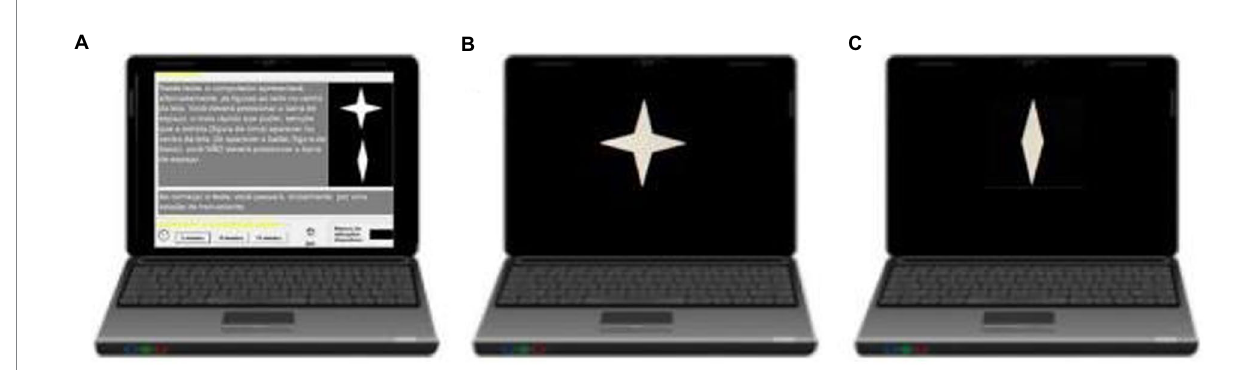
FIGURE 1 Computer visual attention test (CVAT). The test begins with written instructions on the screen (A) . The target (B) remains on the screen for 250 ms. The non-target (C) remains on the screen for 250 ms. Inter-stimulus time interval is 1 s. The test lasts 90 s. Instructions in English goes as follows: “In this test, the computer alternately displays the indicated figures in the center of the screen. You must press the spacebar using your dominant hand as fast as you can whenever the star appears in the center of the screen. If the other figure appears, you should not press the space bar.” Adapted from Schmidt et al.